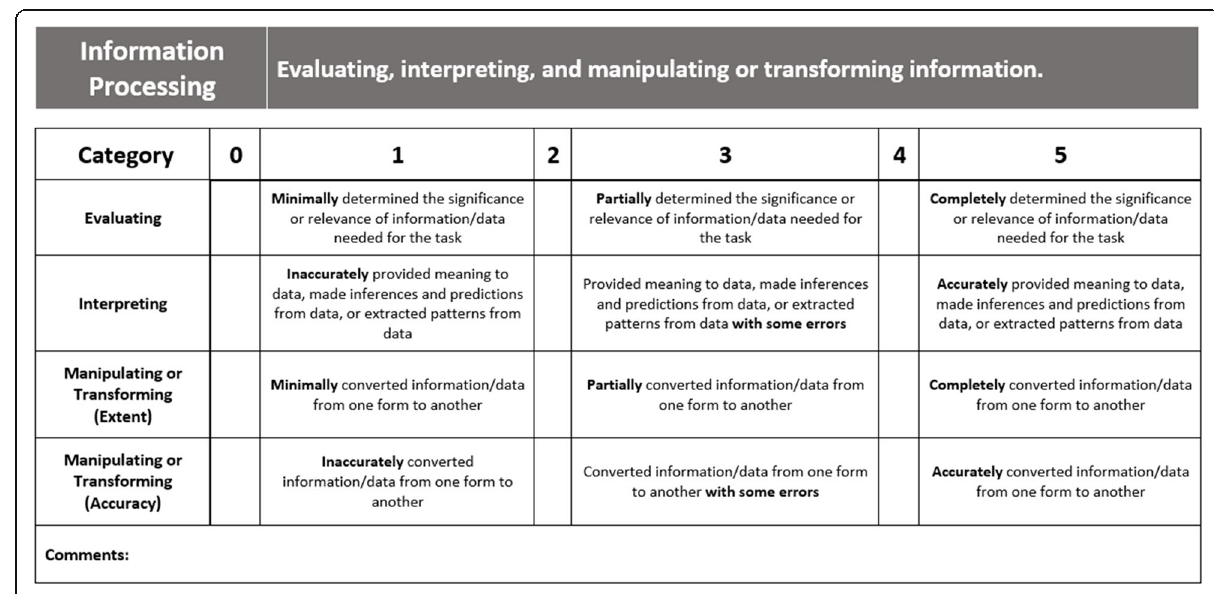
Fig. 1 Rubric for assessing information